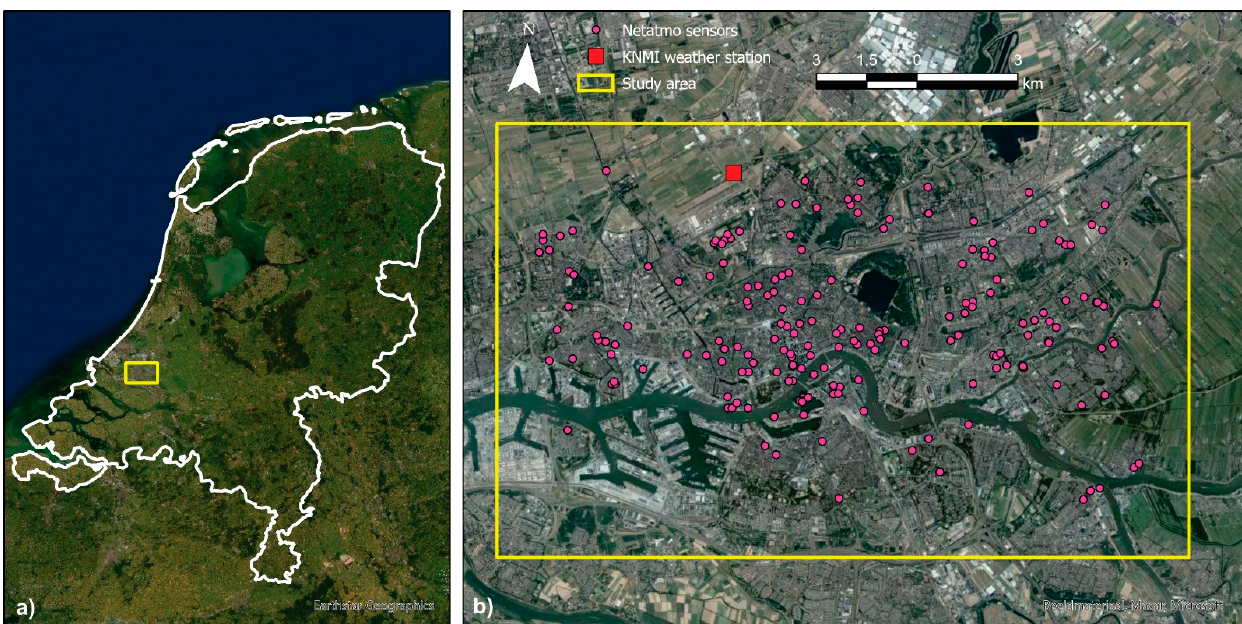
Figure 2. The study area is the urban part of Rotterdam. ( a ) The Netherlands and the location of the study area. ( b ) Study area (Rotterdam city), The Royal Netherlands Meteorological Institute (KNMI) weather station and 193 Netatmo sensors .